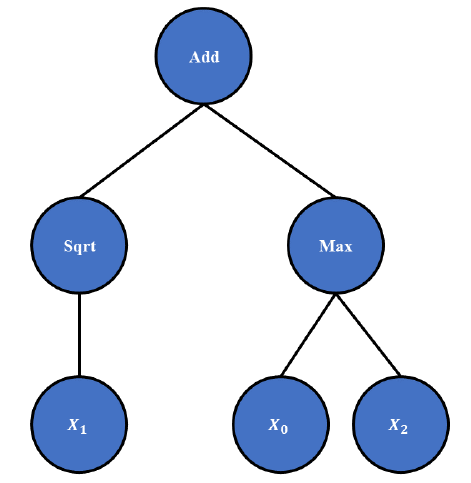
Figure 4. The example of symbolic expression add ( sqrt ( X 1 ) , max ( X 0 , X 2 )) in tree